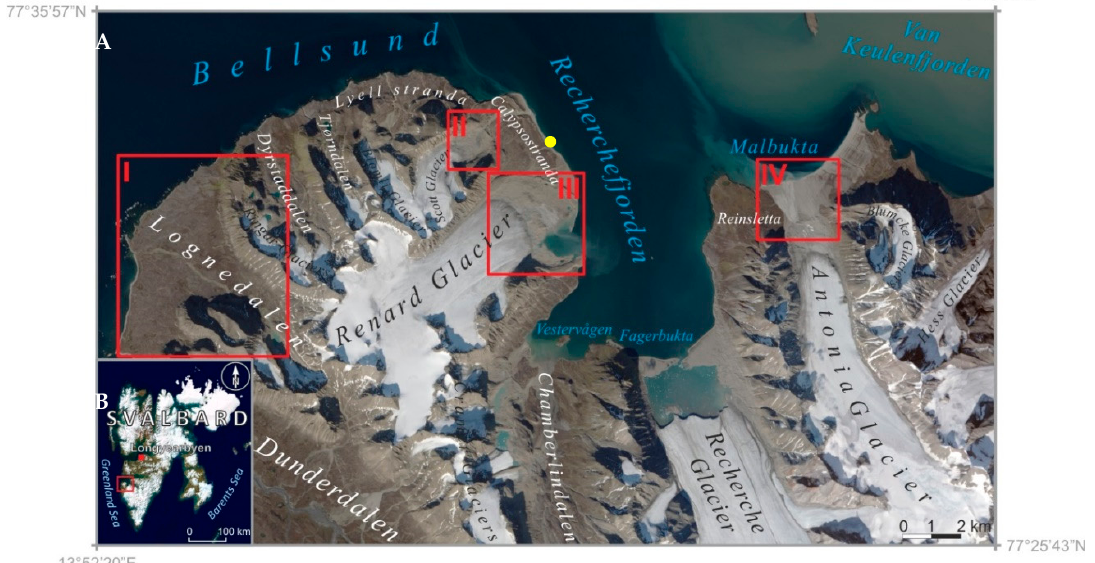
Figure 1. Location of the study area: I—Logne Valley; 2—intra-marginal zone of the Scott Glacier; III—intramarginal zone of Renard Glacier; IV—extra-marginal zone of Antonia Glacier and location of automatic weather station (yellow dot). Source of aerial photo: A [36], B [37].